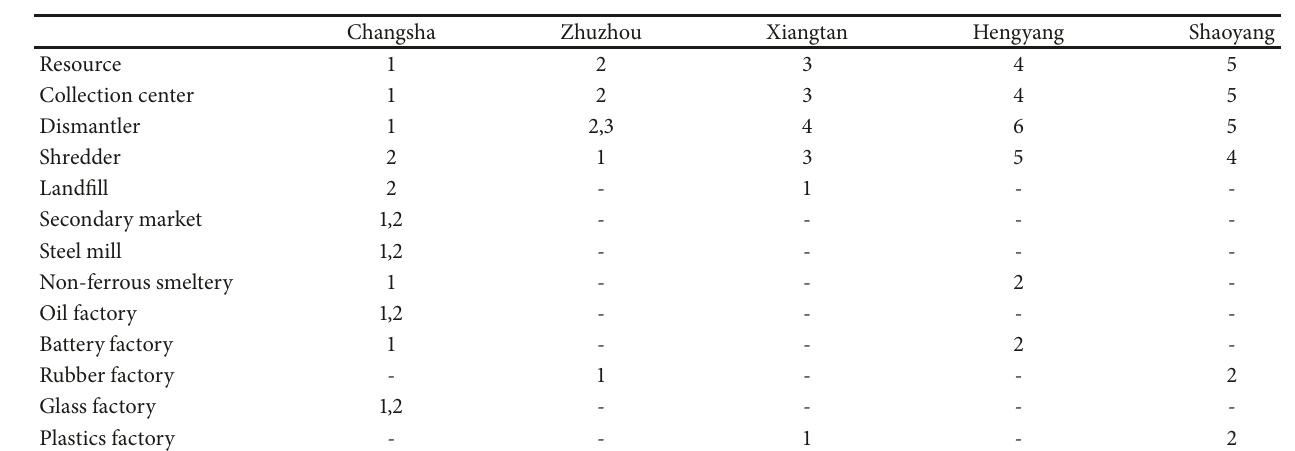
Table 3: Distance between areas (km).